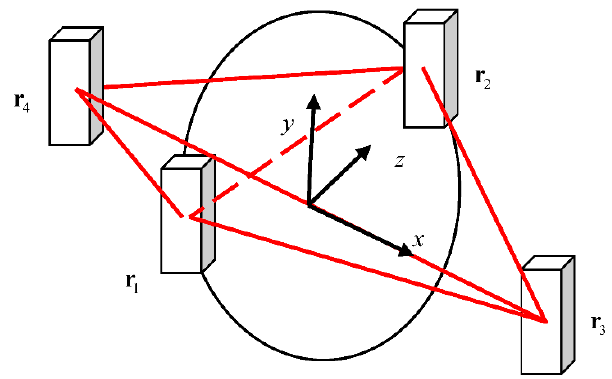
where r i = [ x i y i z i ] T represents the radius-vector of i -th satellite in the orbital reference frame and A and D are constants. According to that equation, two of the satellites were moving along the same the circular path with a constant separation equal to 2 D . The other two satellites were moving along the circular relative trajectories with the angular separation shown in Figure 2.